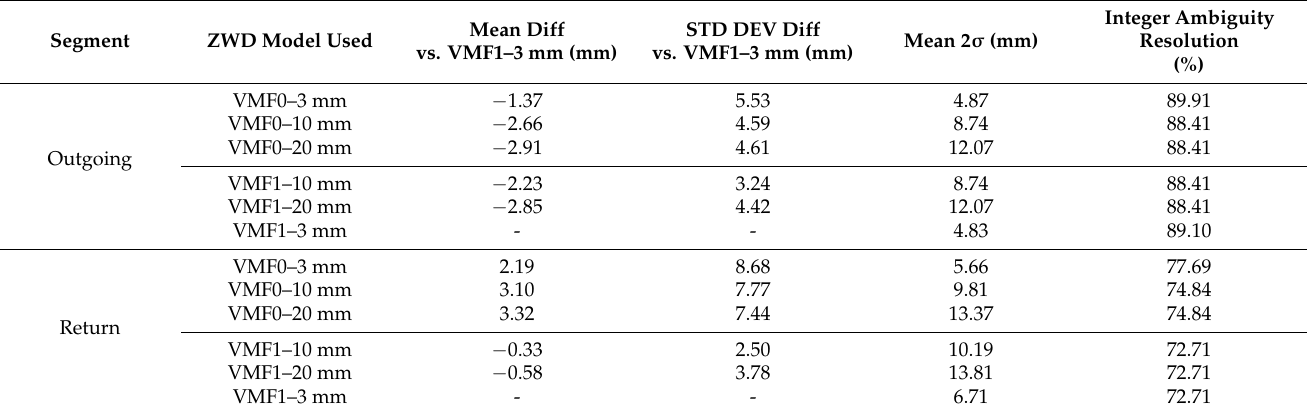
Table 5. Kinematic dataset B ZWD profile mean differences, standard deviations, average 2 σ uncertainties, and integer ambiguity resolution success rates using different ZWD